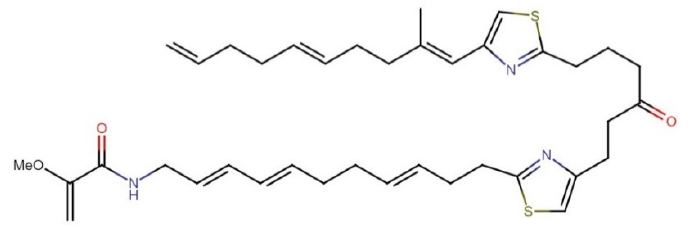
Figure 21. Chemical structure of caldorazole.